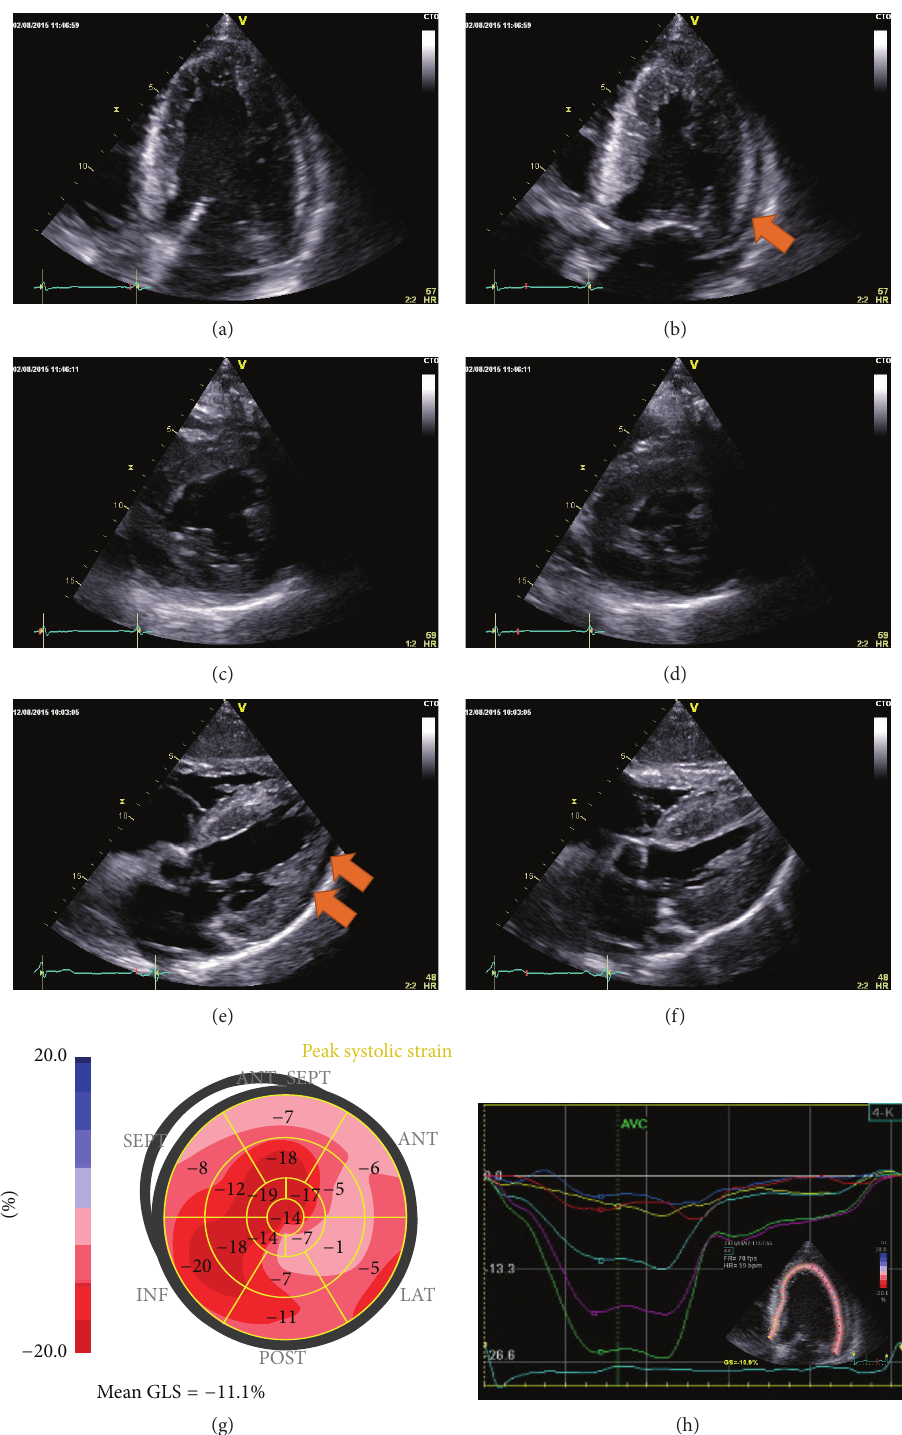
Figure 1: Echocardiographic images revealing severe left ventricular hypertrophy ((a)–(f)). Reduced longitudinal function was noticed in the presence of preserved radial deformation and ejection fraction ((g)-(h)). Minimal pericardial effusion was noticed (orange arrows in (b) and